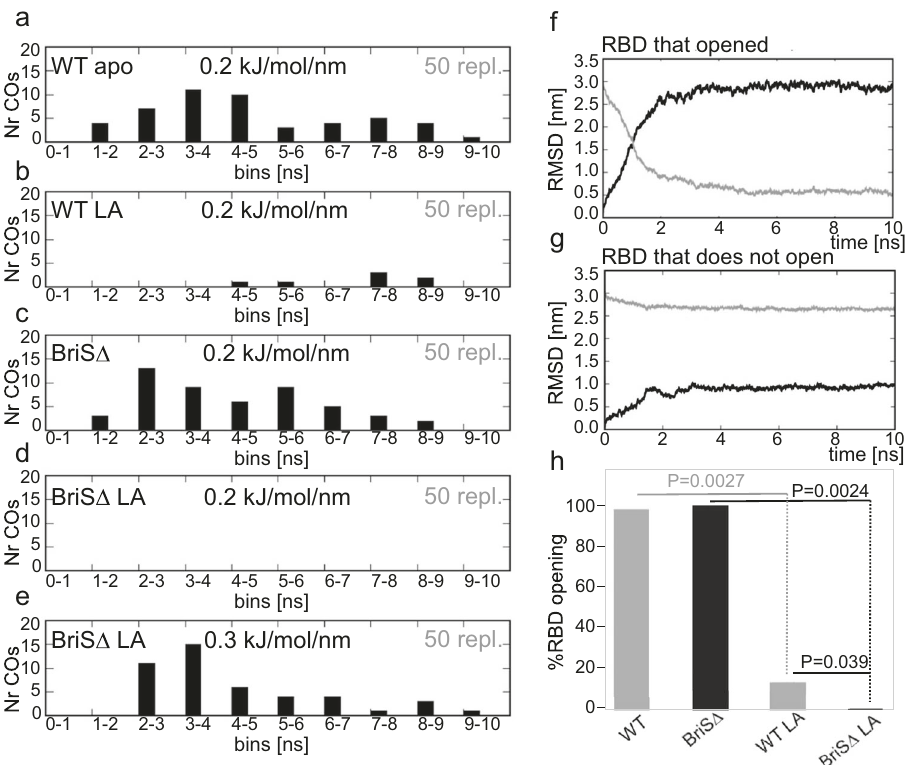
Fig. 4 Impact of furin-site loop deletion and LA binding on RBD opening. a – e Distribution of the cross-overs (COs) for 50 × 10 ns replicates carried out for each of the four spike systems under a force constant of 0.2 kJ/mol/nm for a WT apo, b WT with LA bound c BriS Δ apo and d BriS Δ with LA bound. e Additional force (0.3 kJ/mol/nm) is required to open BriS Δ with LA. f Example of a cross-over plot of a system in which the RBD opens. The black trace shows the RMSD from the closed spike (the starting structure). The gray trace shows the RMSD from the open target at time points along the trajectory over which the force was applied. The point at which the traces cross (the cross-over time) is measured in nanoseconds. g Example of a cross-over plot in which the RBD fails to cross-over as the RBD does not open under the force constant applied. h Comparison of RBD opening events. Signi fi cance of the differences between WT apo form (WT-apo) and WT LA-bound form (WT-LA) ( P = 0.002686262 99% CI), between BriS Δ apo form (BriS Δ -apo) and BriS Δ LA-bound form (BriS Δ -LA) ( P = 0.002445144 99% CI) and WT-LA and BriS Δ -LA ( P = 0.038942552 95% CI) was determined by one-tailed, paired T-test with nine degrees of freedom for each data set. Source data for graphs shown in panels f , g are provided as a Source Data fi